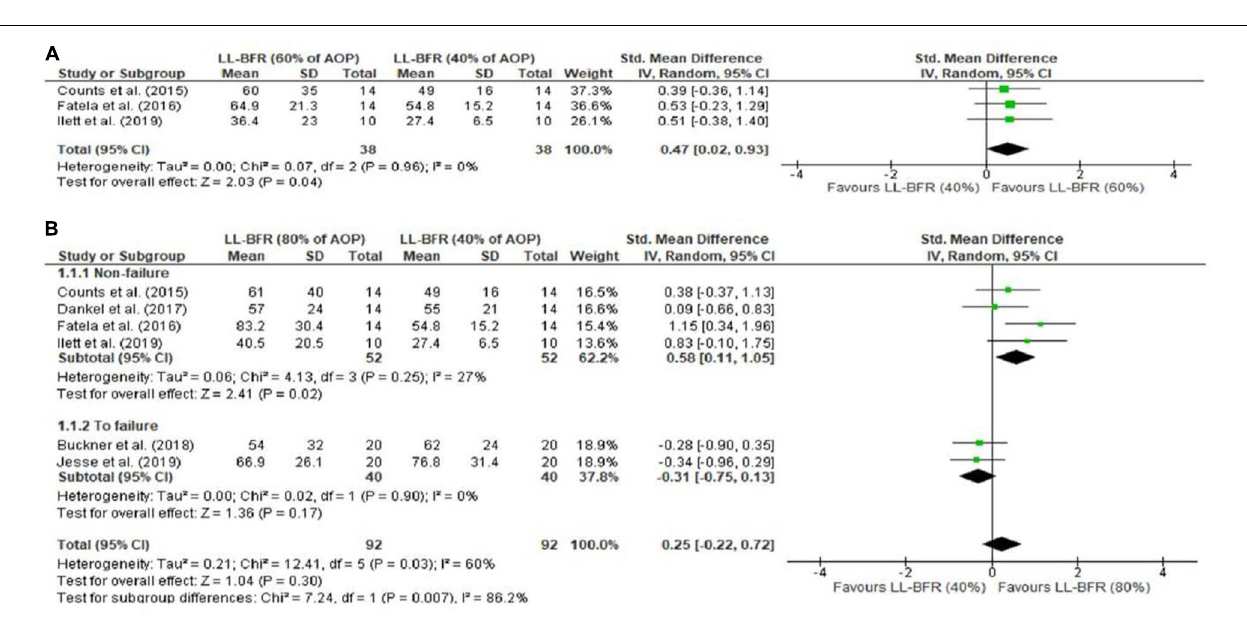
FIGURE 3 | Forest plot illustrating the combined effects for touch MVC of: (A) LL-RE with BFR pressure of 40% AOP vs. LL-RE (NO-BFR); (B) LL-RE with BFR pressure of 80% AOP vs. LL-RE (NO-BFR). 95%CI: confidence interval; AOP: arterial occlusion pressure; LL-BFR: low load + blood flow restriction; LL: low load; SD: standard deviation.